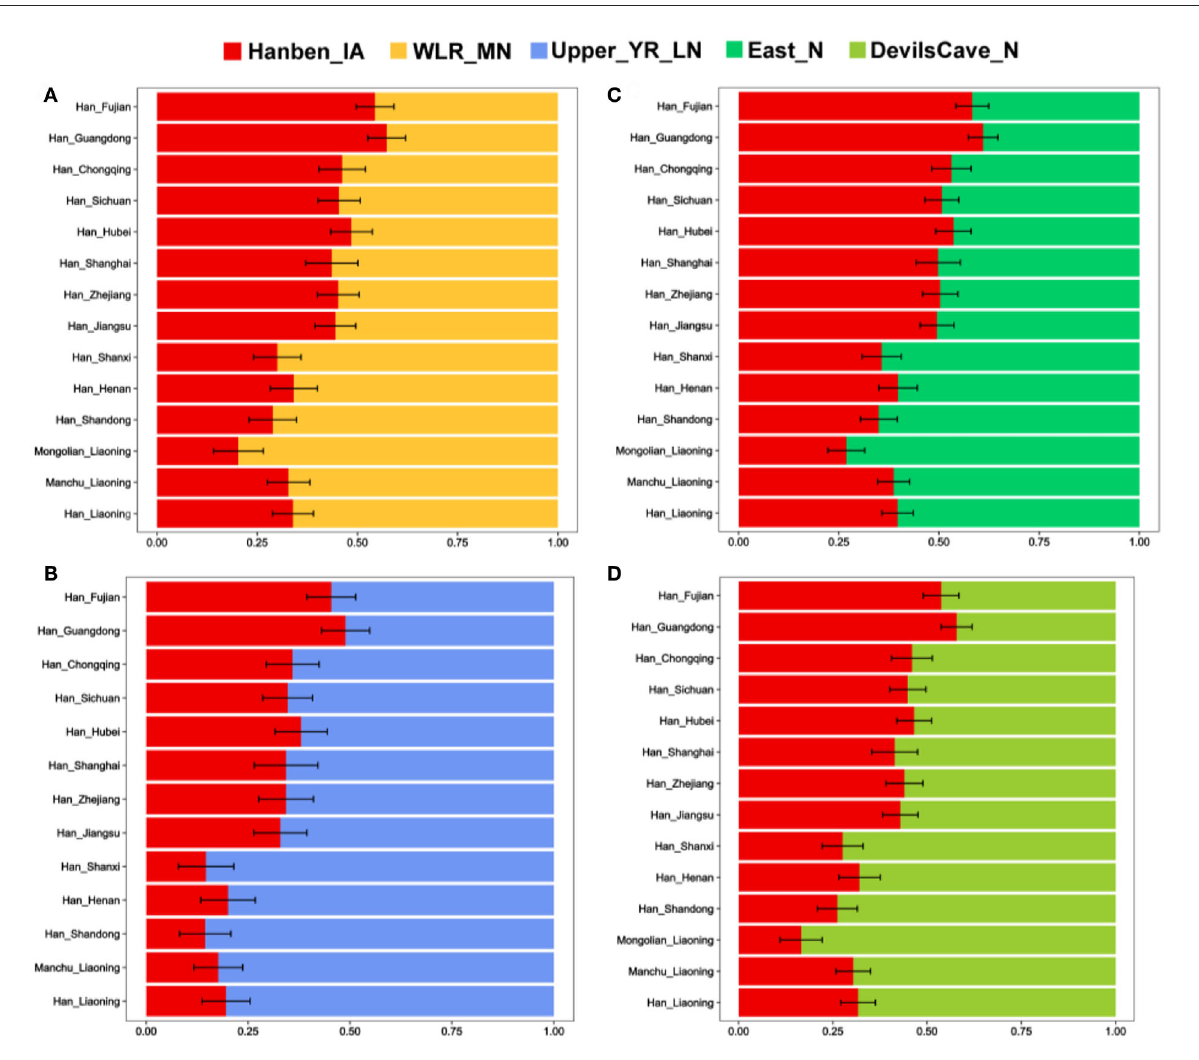
FIGURE6 (A–D) Two-way admixture model among different Han populations constructed based on the “Merged-HO”